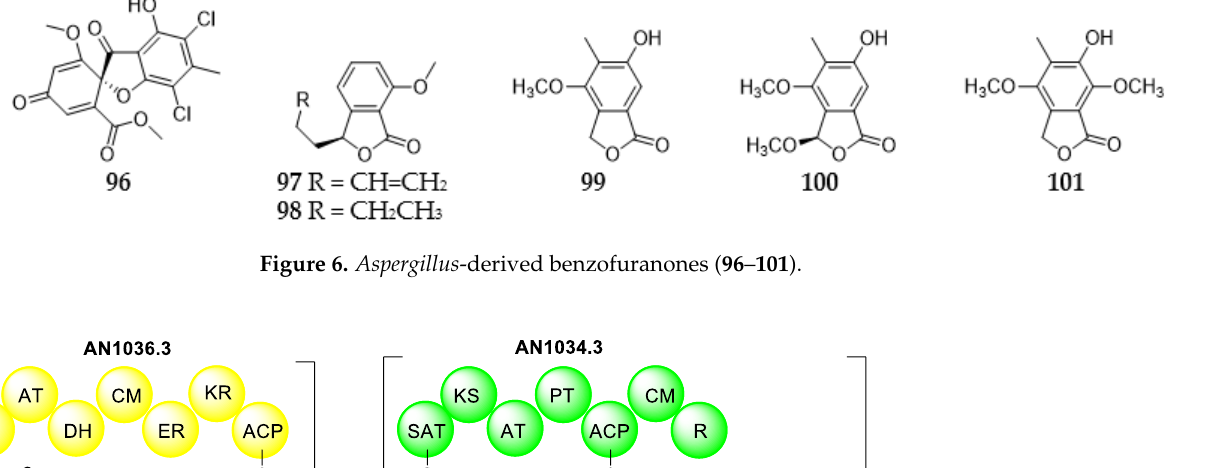
Figure 5. Aspergillus -derived tetrahydrofuranones ( 77 – 95 ).